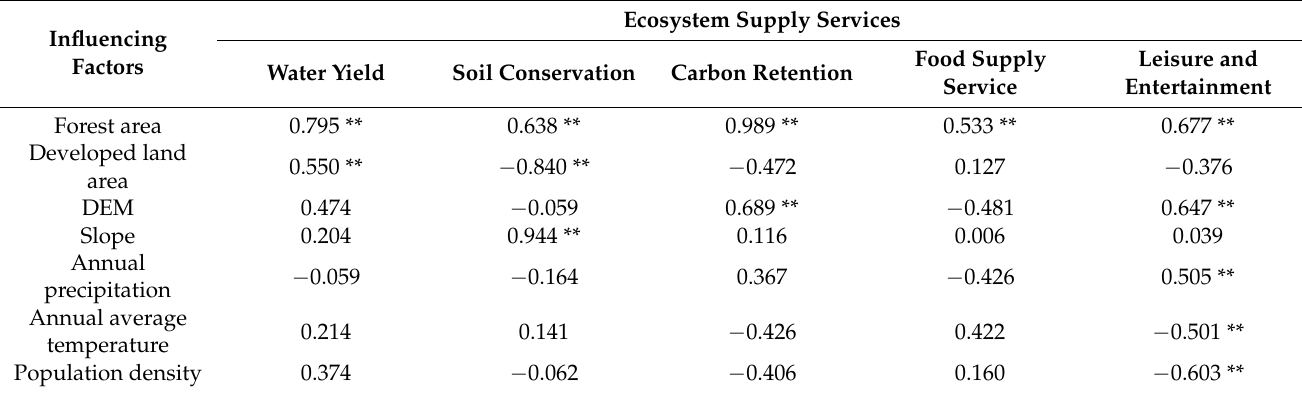
Table 4. Correlations between ecosystem supply services and different indexes/driver